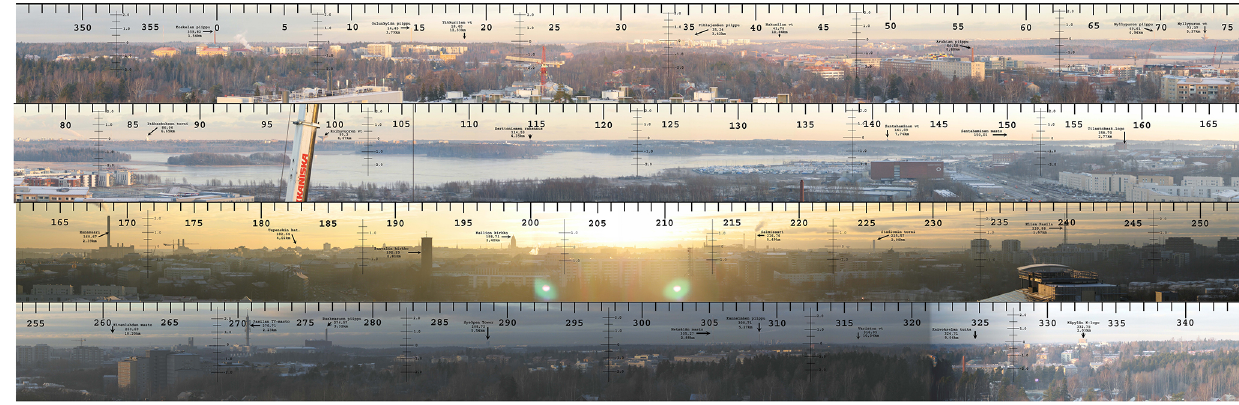
Figure 3. The 360 ◦ panoramic view from the antenna tower of Kumpula radar.